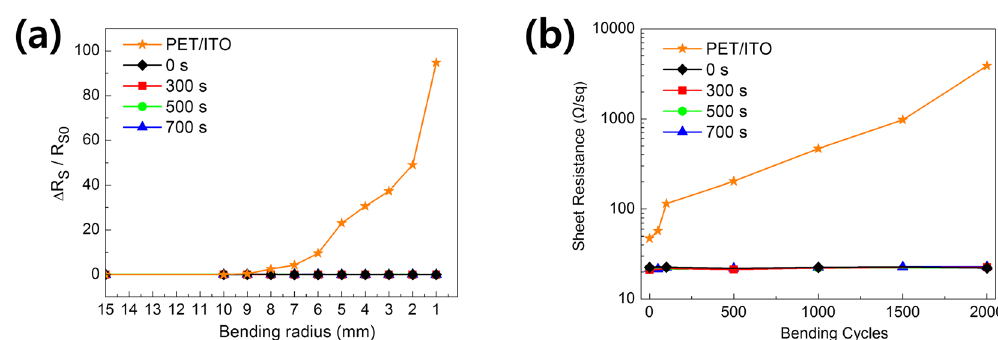
Figure 4. ( a ) Resistance variation of ITO on PET, and AgNW-embedded PVB as a function of bending radius. ( b ) Resistance variation during cyclic test of ITO on PET, and AgNW embedded PVB at a bending radius of 5